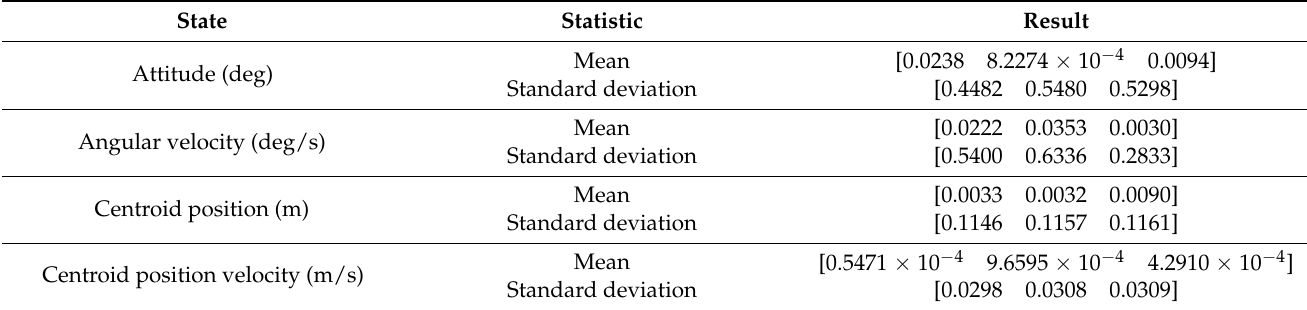
Table 2. Statistics of state